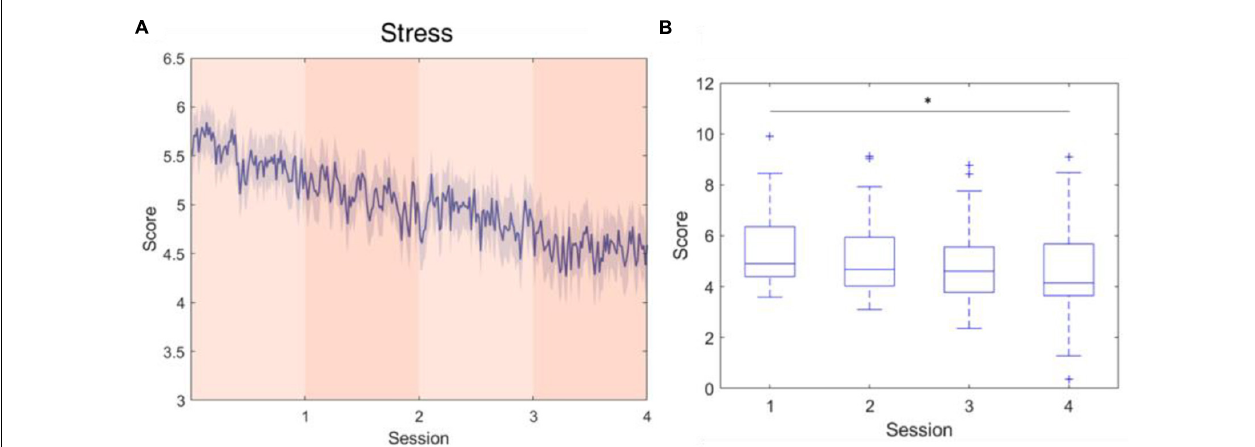
FIGURE 7 | Stress level fluctuations during the active sessions. This parameter was developed using log-transformed alpha-band power at F3 and F4. (A) The average stress level across the four session periods. (B) The stress level significantly decreased over time. *indicates that the difference between the two groups was statistically significant. The whiskers extend to the most extreme data points not considered outliers, and the outliers are plotted individually using the “+” marker